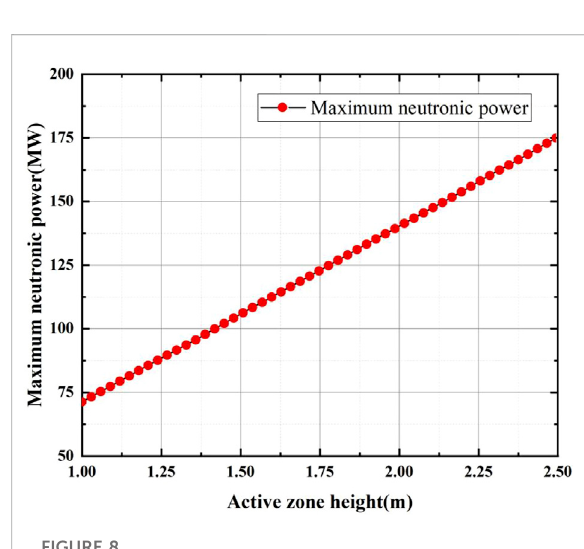
FIGURE 8 Maximum neutronic power of the SPALLER reactor at different